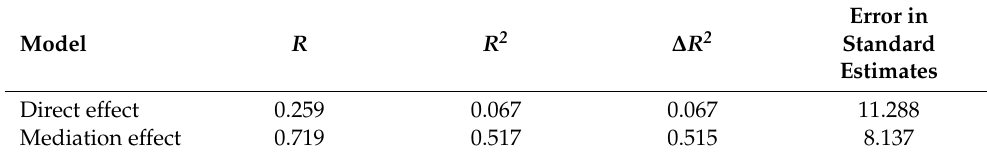
Figure 2. The path chart of predicting depression by school bullying and Big Five personality. Note: ** P < 0.01, the value on the arrow indicates the B value of the regression coefficient. Table 4. The model explains the change.